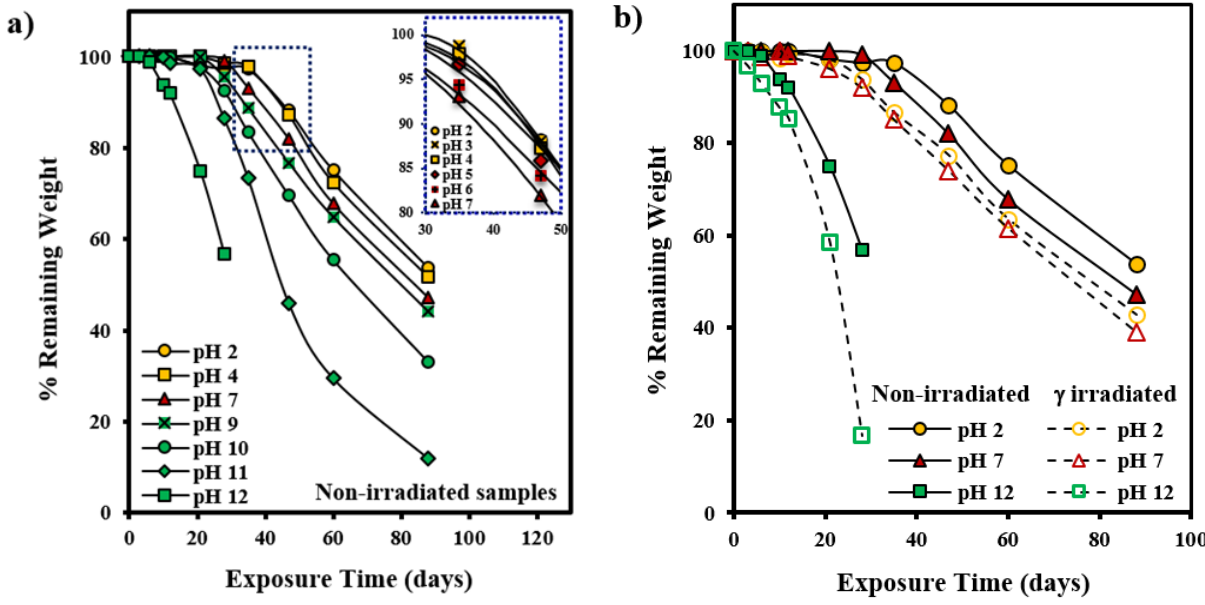
Figure 2. ( a ) Plot of remaining weight percentage versus exposure time to the different assayed hydrolytic degradation media for non-irradiated GL- b -[GL- co -TMC- co -CL]- b -GL samples. The inset shows a magnification for low pH media; ( b ) Comparison between degradation of non-irradiated and γ irradiated GL- b -[GL- co -TMC- co -CL]- b -GL samples during exposure to different representative degradation